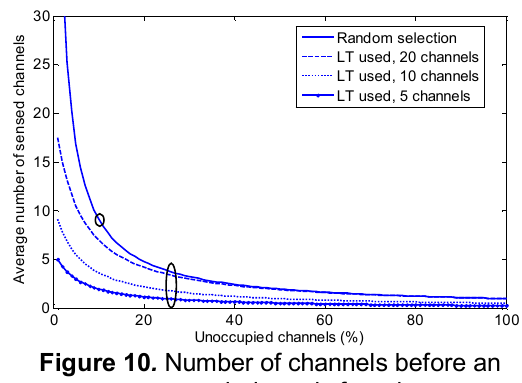
Figure 10 . Number of channels before an unoccupied one is found.